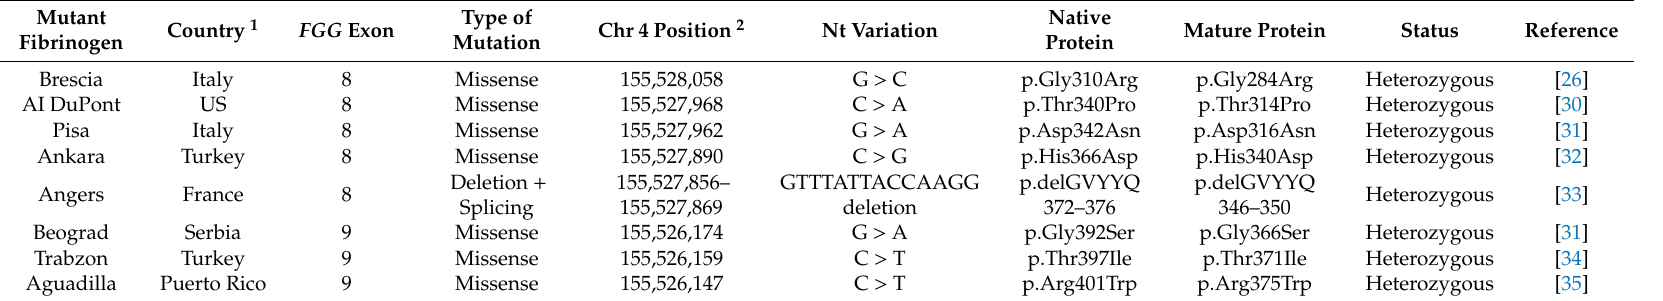
Table 2. HHHS mutations described in the literature so